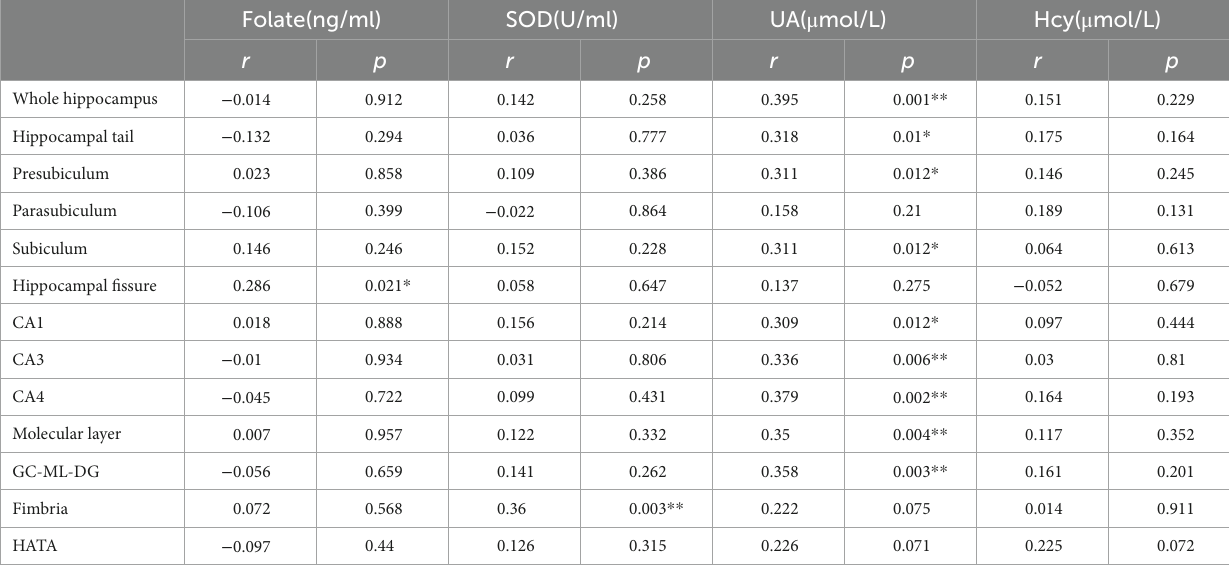
TABLE 3 Relationships between oxidative stress and hippocampal subfield volumes (mm 3 ) in patients with schizophrenia controlling for age and